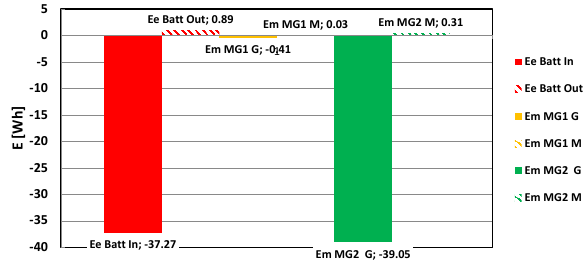
Fig. 6. Energy distribution in the hybrid drive system during